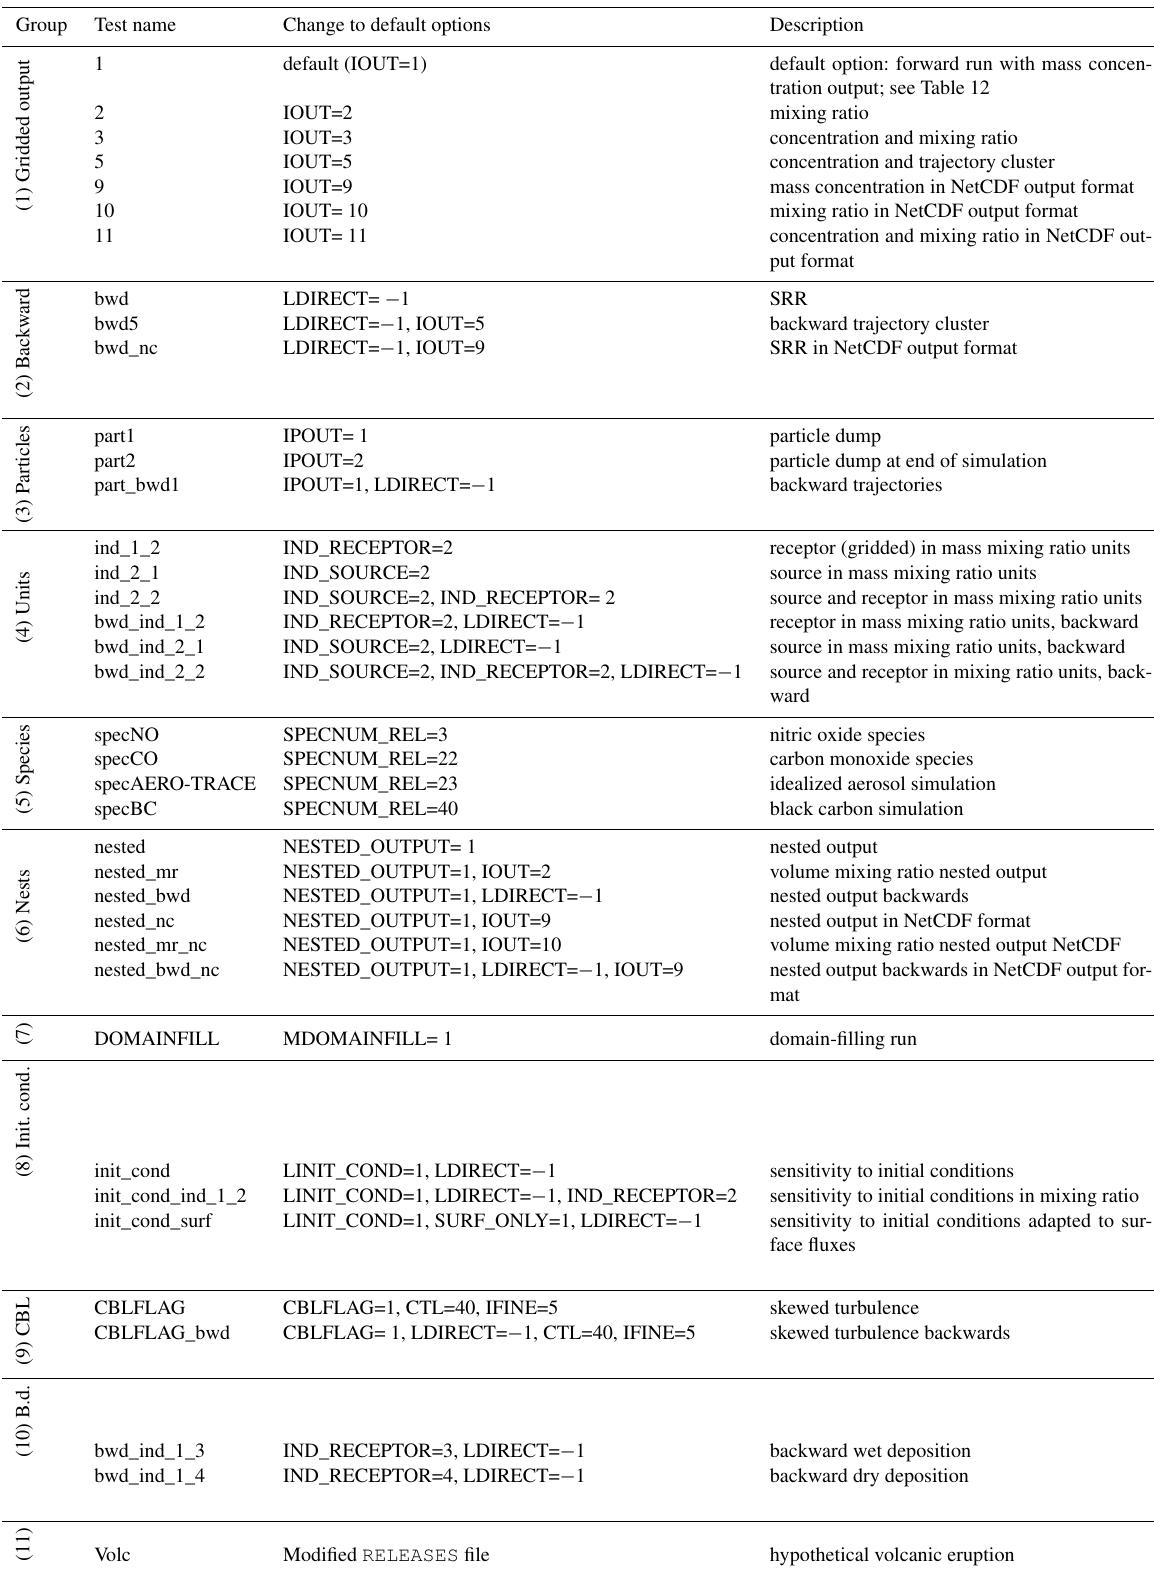
Table 14. List of the test cases for FLEXPART 10.4.